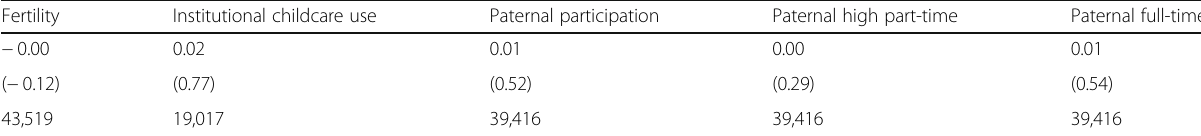
Table 6 Difference-in-differences estimates of the impact of the reform on fertility rates, use of institutional childcare and paternal employment Fertility Institutional childcare use Paternal participation Paternal high